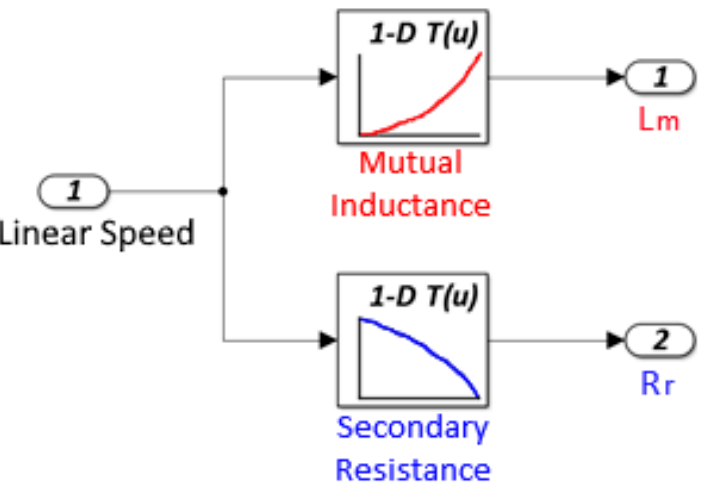
Figure 9. Look-up table structure for calculation of the secondary resistance and the magnetic inductance.